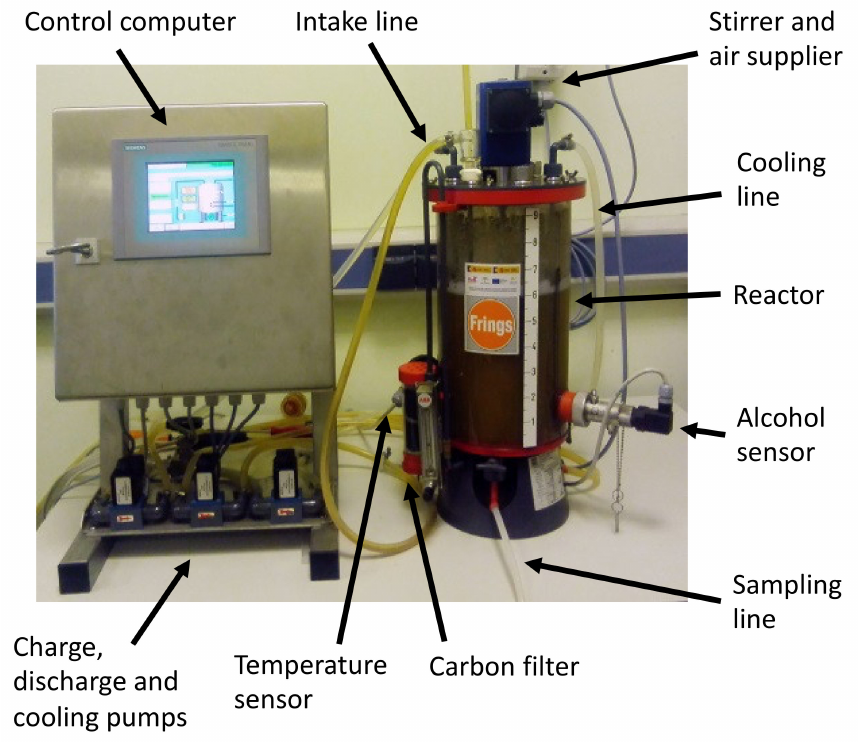
Figure 4. Typical system for submerged culture